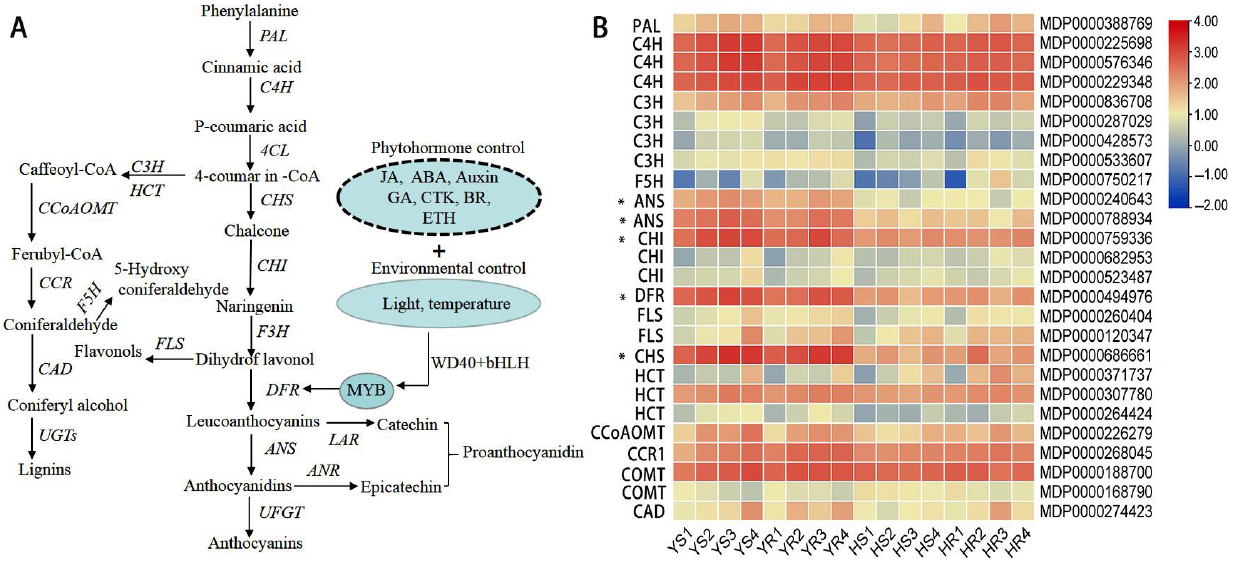
Figure 4. Overview of phenylpropanoid pathway modulation and the expression levels of genes with correlation coefficients with anthocyanin accumulation >0.7. ( A ) Genes related to the phenylpropanoid pathway. The content in the dashed box represents speculation. ( B ) Heat map of structure gene expression levels. Different colors represent the expression level of downregulated or upregulated genes under treatments standardized with log 10 . The asterisk (*) indicates that the expression level of this transcript is significantly higher in YS and YR than in HS and HR.